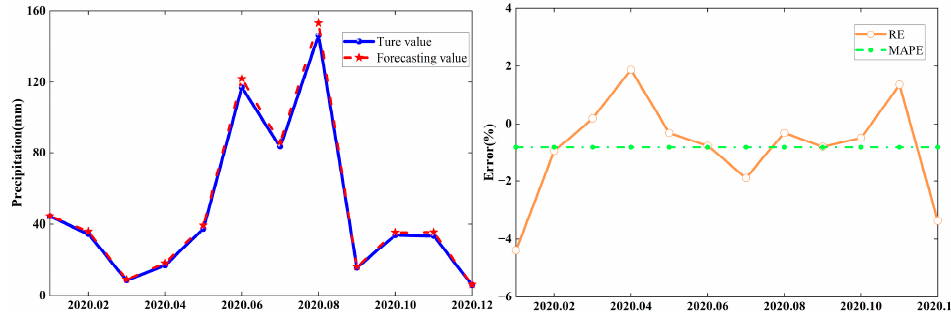
Figure 8. Precipitation prediction curve of Zhengzhou Station in 2020.